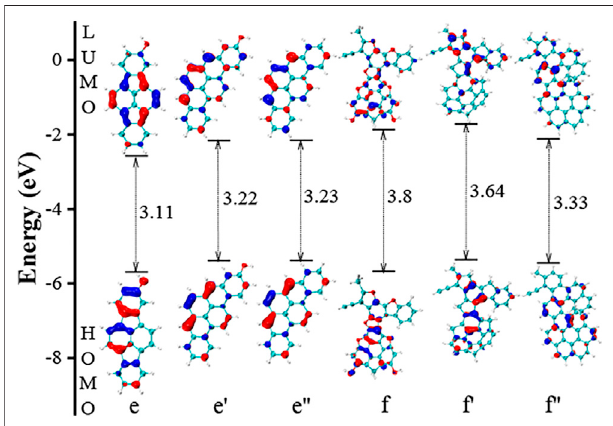
FIGURE 5 | The HOMO and LUMO electronic structures of PAHs with – OH substitutions. The e ’ and e ’’ are two simpli fi ed con fi gurations of e by removing fi ve-memberringsand – OHfunctionalgroup,respectively.Thefuran